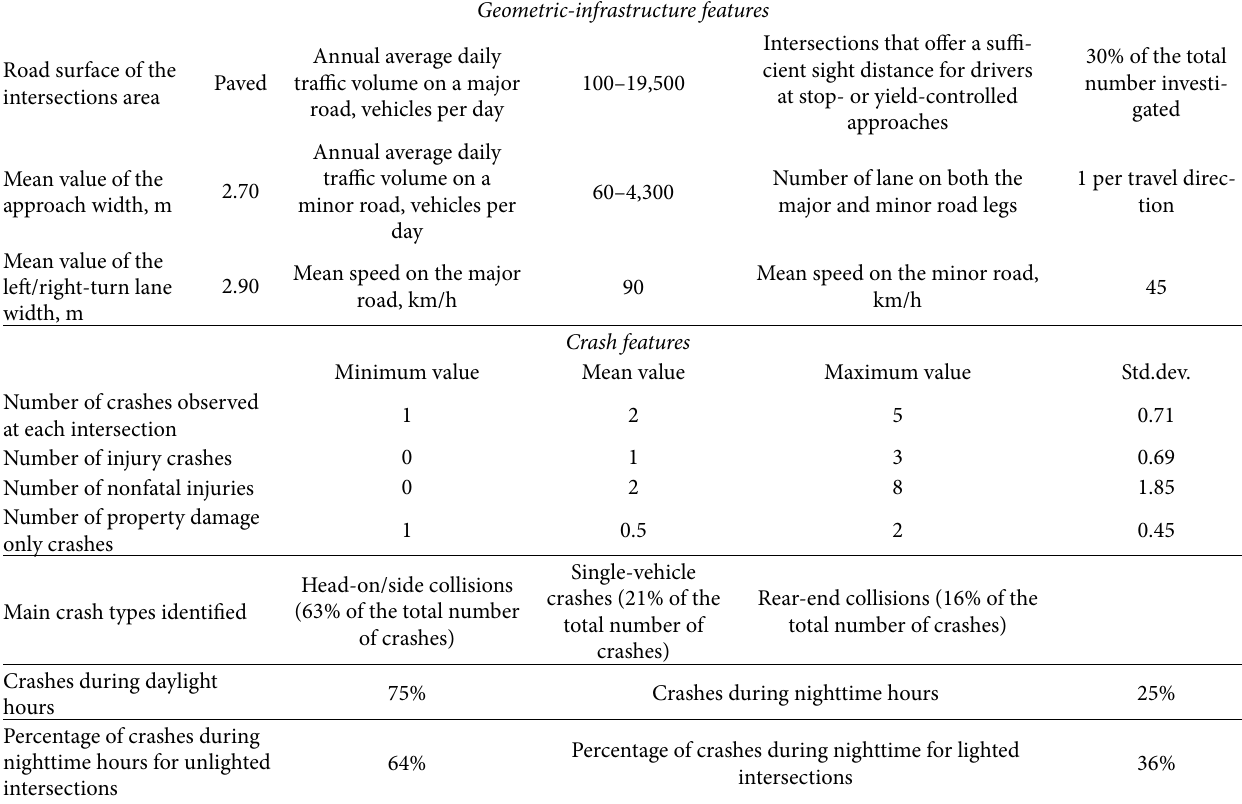
Table 1: Overview of the main infrastructure-geometric and crash features at the intersections in a 5-year period. Geometric-infrastructure